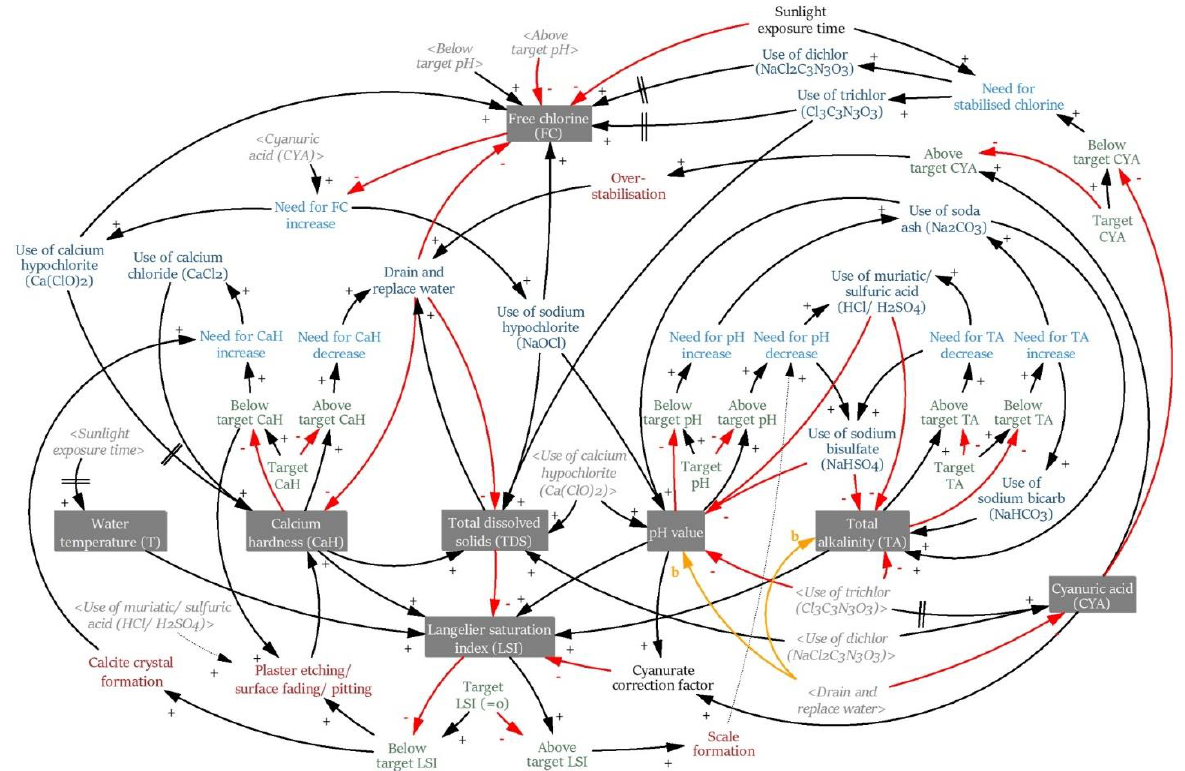
Figure 4. CLD 1: Essential swimming pool chemistry. Colour code (variables): red—SP(W) issues, green—desired state of variable, blue—SP(W) solutions, action to achieve a desired state, grey/italic—‘shadow variable’, i.e., a variable that is described elsewhere in the CLD; and (arrows): yellow (b)—both directional (+ or −). Dotted—link may accidentally be established, but occurrence is unlikely.